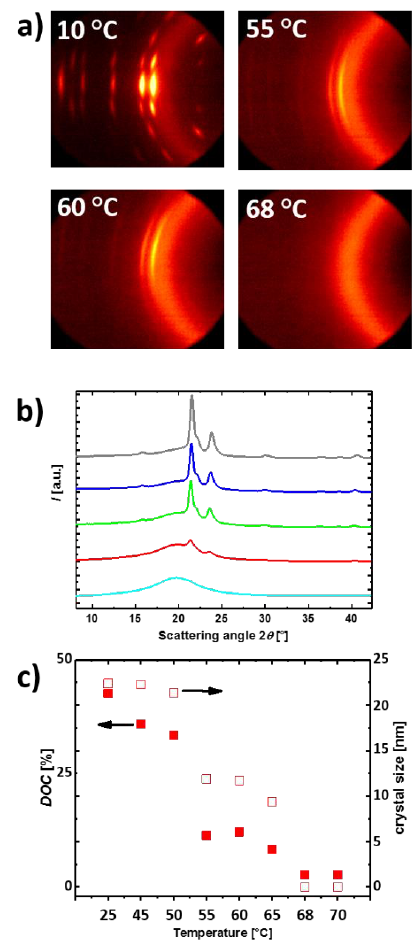
Figure 5. ( a ) Series of 2D WAXS scattering pattern of cPCL 70 -L 30 at different temperatures; ( b ) Scattering intensity curves from WAXS of cPCL 70 -L 30 at 25 (grey line), 50 (blue line), 55 (green line), 60 (red line) and 65 °C (cyan line); ( c ) Temperature dependent evolution of the DOC and crystal size for cPCL 70 -L 30 determined from X-ray scattering.